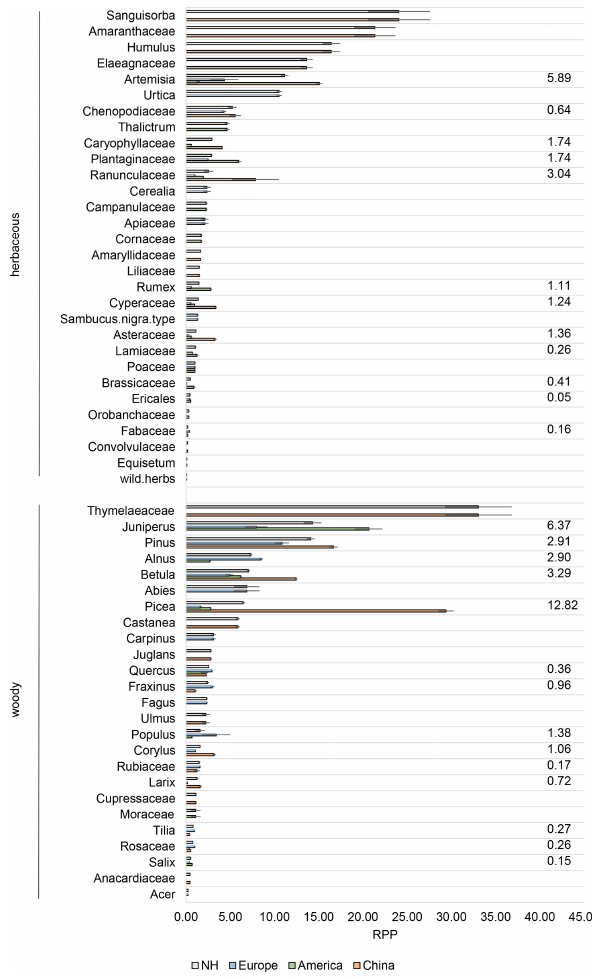
Figure 3. Relative pollen productivity (RPP) dataset v2 including subsetted continental mean RPP values with their standard error (SE), calculated with the delta method (see Sect. 2). Numbers to the right are the standard deviation (SD) between continental datasets, NH is Northern